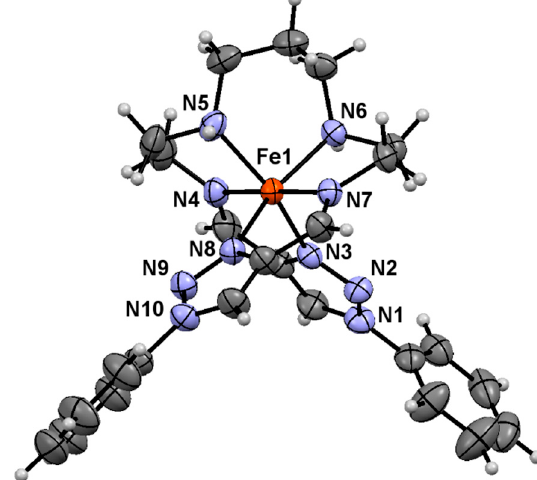
Figure 5. ORTEP drawing of the complex cation [Fe(L 2-3-2Ph )] 2+ of 1 at 296 K with the atom numbering scheme, except for carbon and hydrogen atoms, where the thermal ellipsoids are drawn with a 50% probability level.